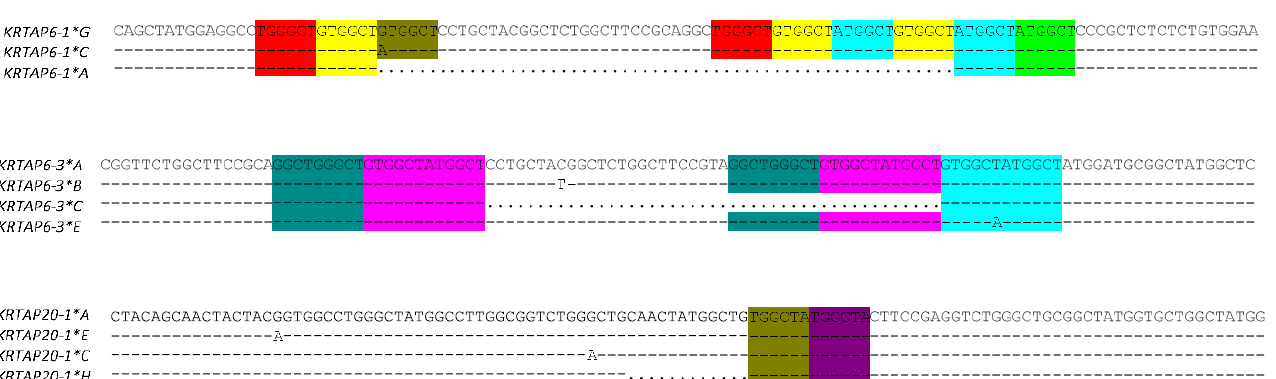
Figure 4. The indels identified in ovine KRTAP6-1 , KRTAP6-3 , and KRTAP20-1 . The sequence repeats flanking the indels are shaded in different colours. In the region that is shown, variants B , D , E , and F of ovine KRTAP6-1 have a sequence identical to ovine KRTAP6-1 variant A; variants D and F of ovine KRTAP6-3 have a sequence identical to the ovine KRTAP6-3 variant A ; and variants B , D , F , and G of ovine KRTAP20-1 have a sequence identical to ovine KRTAP20-1 variant A ; hence, only one variant from the identical sequences is shown.